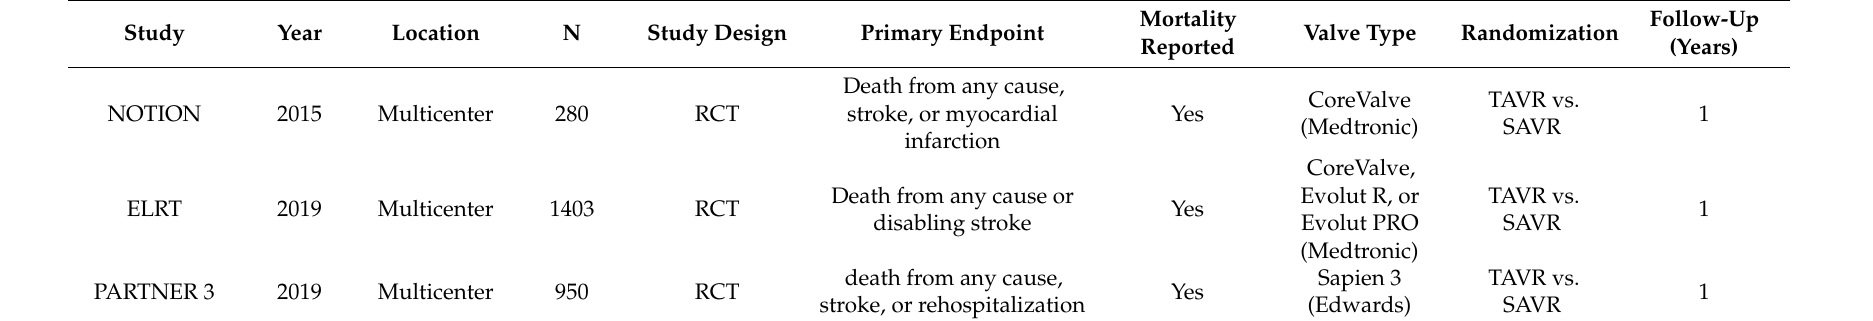
Table 1. Characteristics and endpoint definitions of included randomized trials.